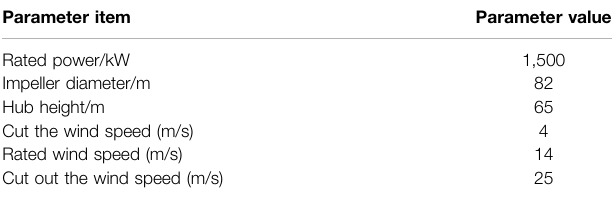
TABLE 1 | The main parameters of the wind turbine tested.